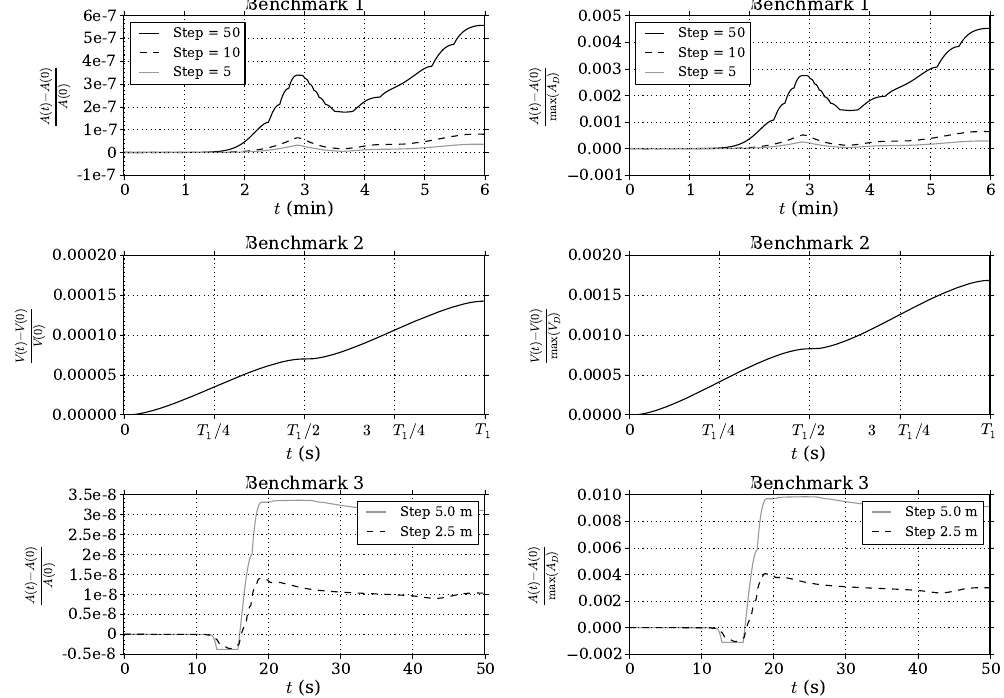
Fig. 15. Mass conservation: time histories of the variation of the total (left column) and displaced (right column) volume/area are plotted for cases treated in benchmarks 1 and 2 as well for the specific case of benchmark 3.